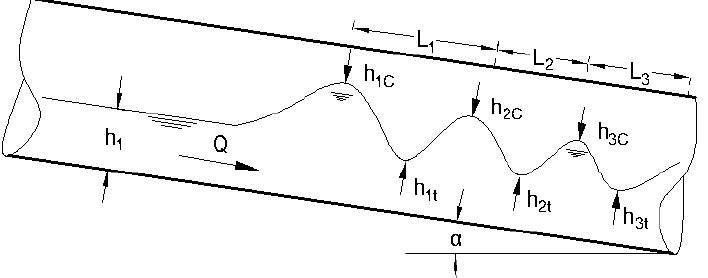
Figure 3. Undular hydraulic jump in a sloping sewer pipe, showing the elevations of the first to third wave crests h 1 c , h 2 c , and h 3 c ; wave troughs h 1 t , h 2 t , and h 3 t above the invert of the sewer pipe; and distances L 1 , L 2 , and L 3 between adjacent wave crests. Here, h 1 is the depth of approach flow; α is the inclination angle of the sewer pipe from the